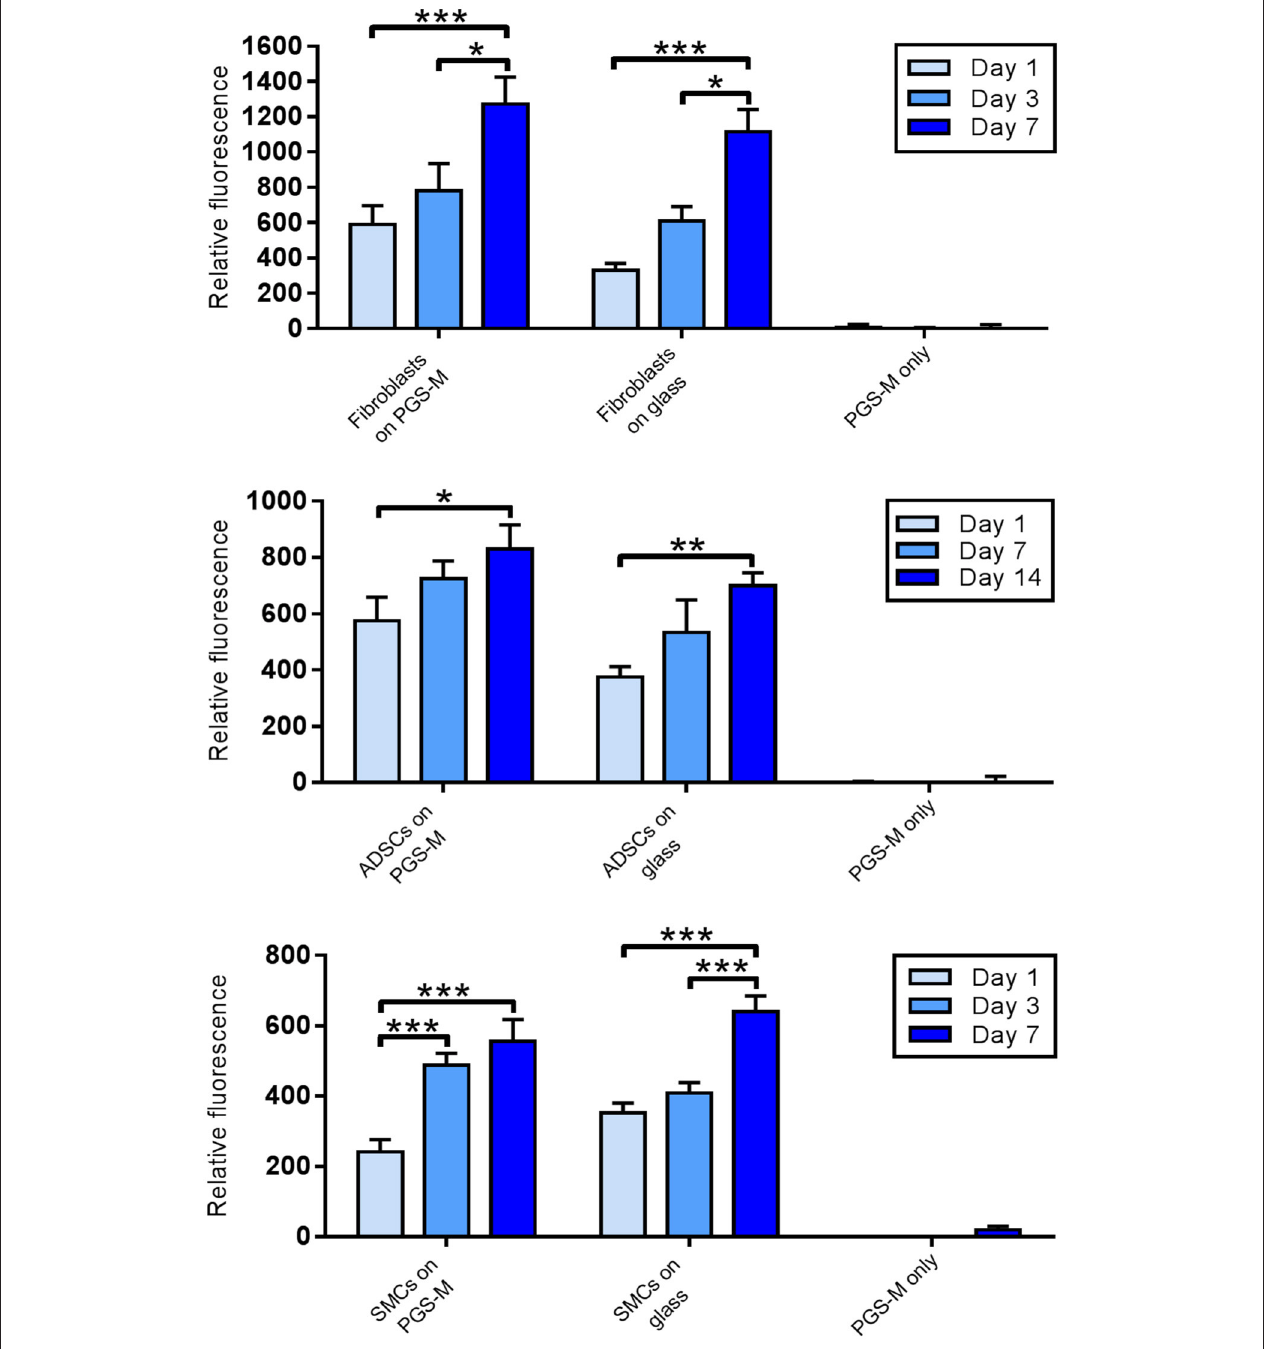
FIGURE 10 | Resazurin reduction assay for viability of fibroblasts, ABSCs and SMCs on 30% Low M w PGS-M surfaces. Positive controls were cells cultured on borosilicate glass. Negative controls were unseeded PGS-M surfaces (PGS-M only) ( n = 3). The degree of significance is indicated as *** P ≤ 0.001, ** P ≤ 0.01 and * P ≤